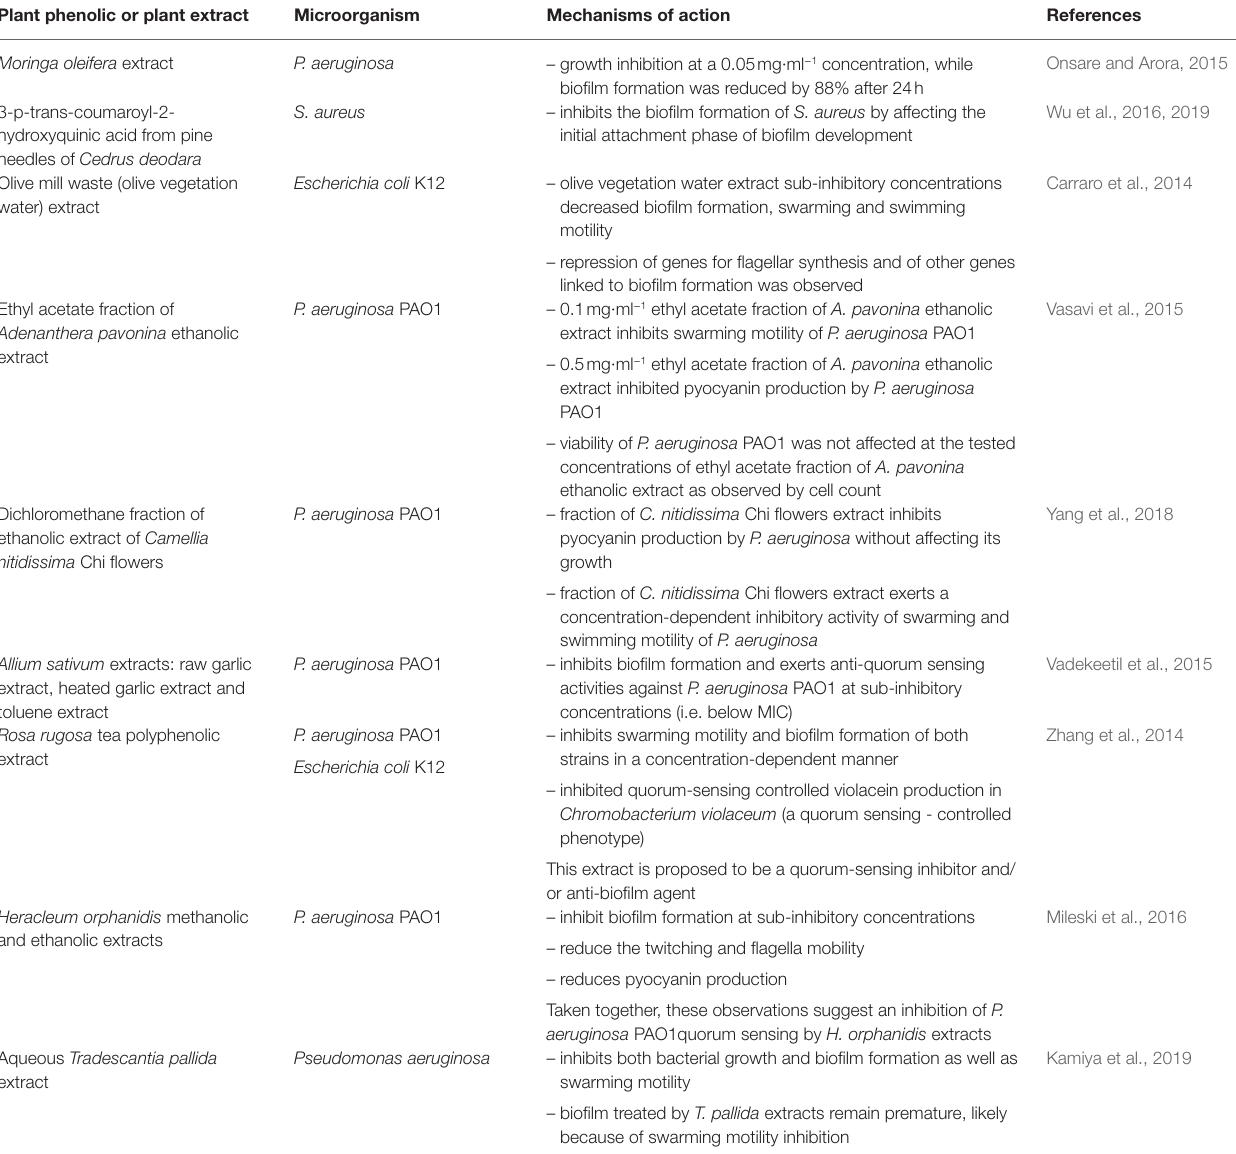
TABLE 4 | Examples of plant phenolics or phenolic-rich plant extracts acting against biofilms by different mechanisms of